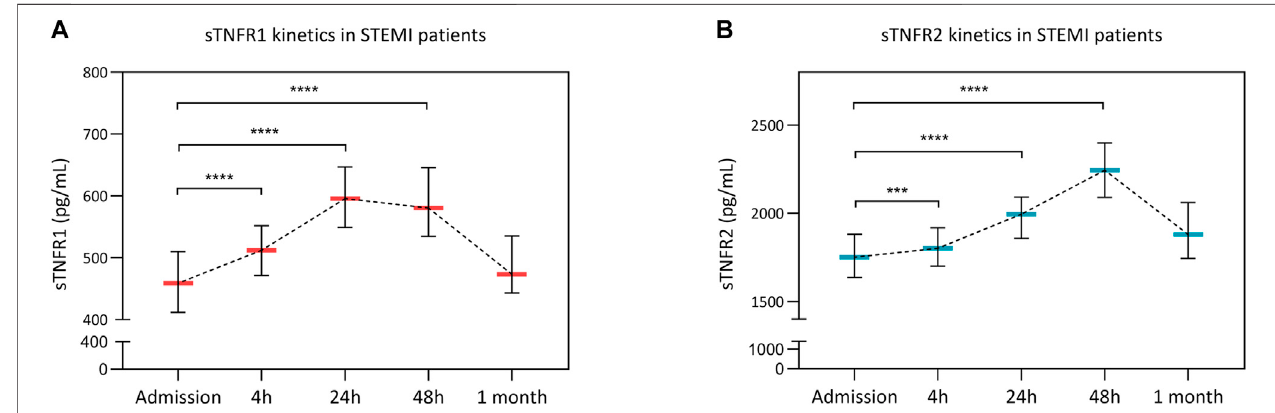
FIGURE 1 | Soluble tumor necrosis factor receptor 1 (sTNFR1) and sTNFR2 kinetics after STEMI. Circulating concentrations of sTNFR1 (A) and sTNFR2 (B) at admission and 4, 12, 48 h, and 1 month after PCI revascularization are presented. Time points were compared using the Kruskal – Wallis test. ** p < 0.01, **** p < 0.0001 versus